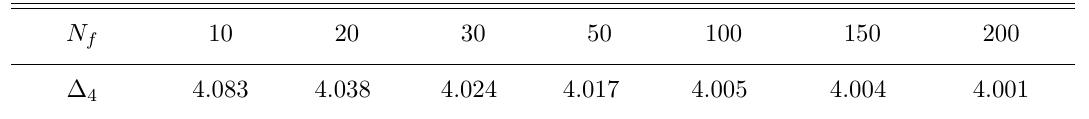
Table 2 . Linear extrapolations of the upper bounds on ∆ 4 ( ’ 4 in QED 3 with large N f ) with ∆ O fixed at the 1 /N f results. The upper bounds are not sensitive to the gap ∆ ∗ in the